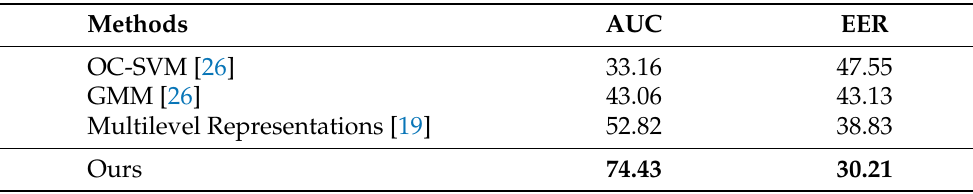
Table 5. Pixel-level AUC and EER performance of abnormal object localization on Avenue dataset. The best performance on each dataset is highlighted by bold number.